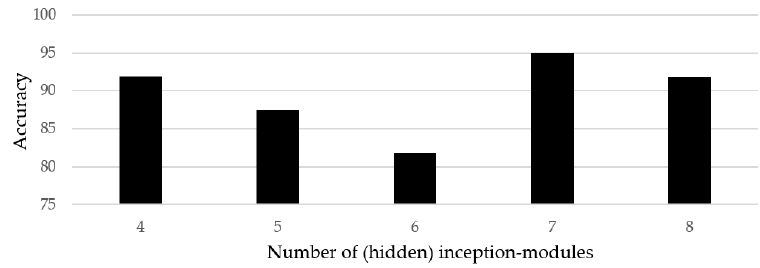
Figure 16. Results of classification accuracy for different numbers of inception-modules.